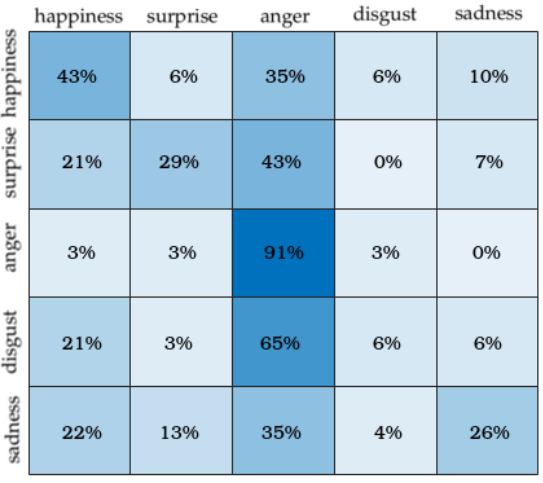
Figure 8. Confusion matrix obtained by the work of